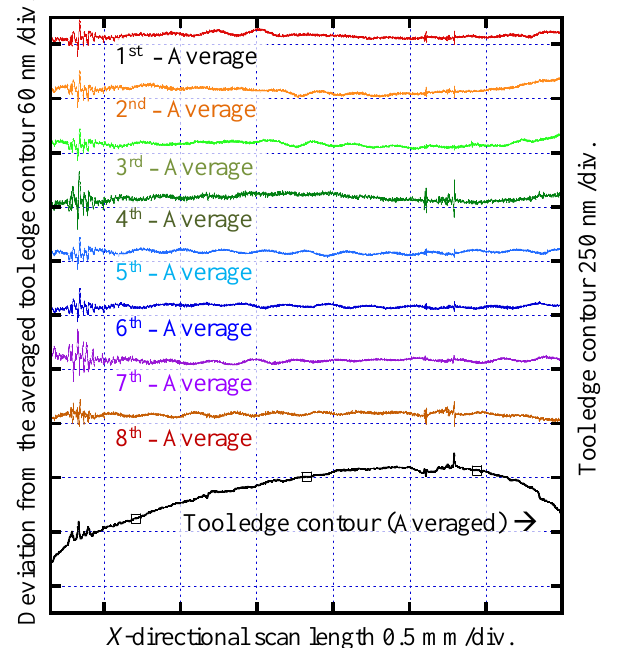
Figure 9. Averaged measurement result of a flat-shaped cutting edge from eight measurements and their